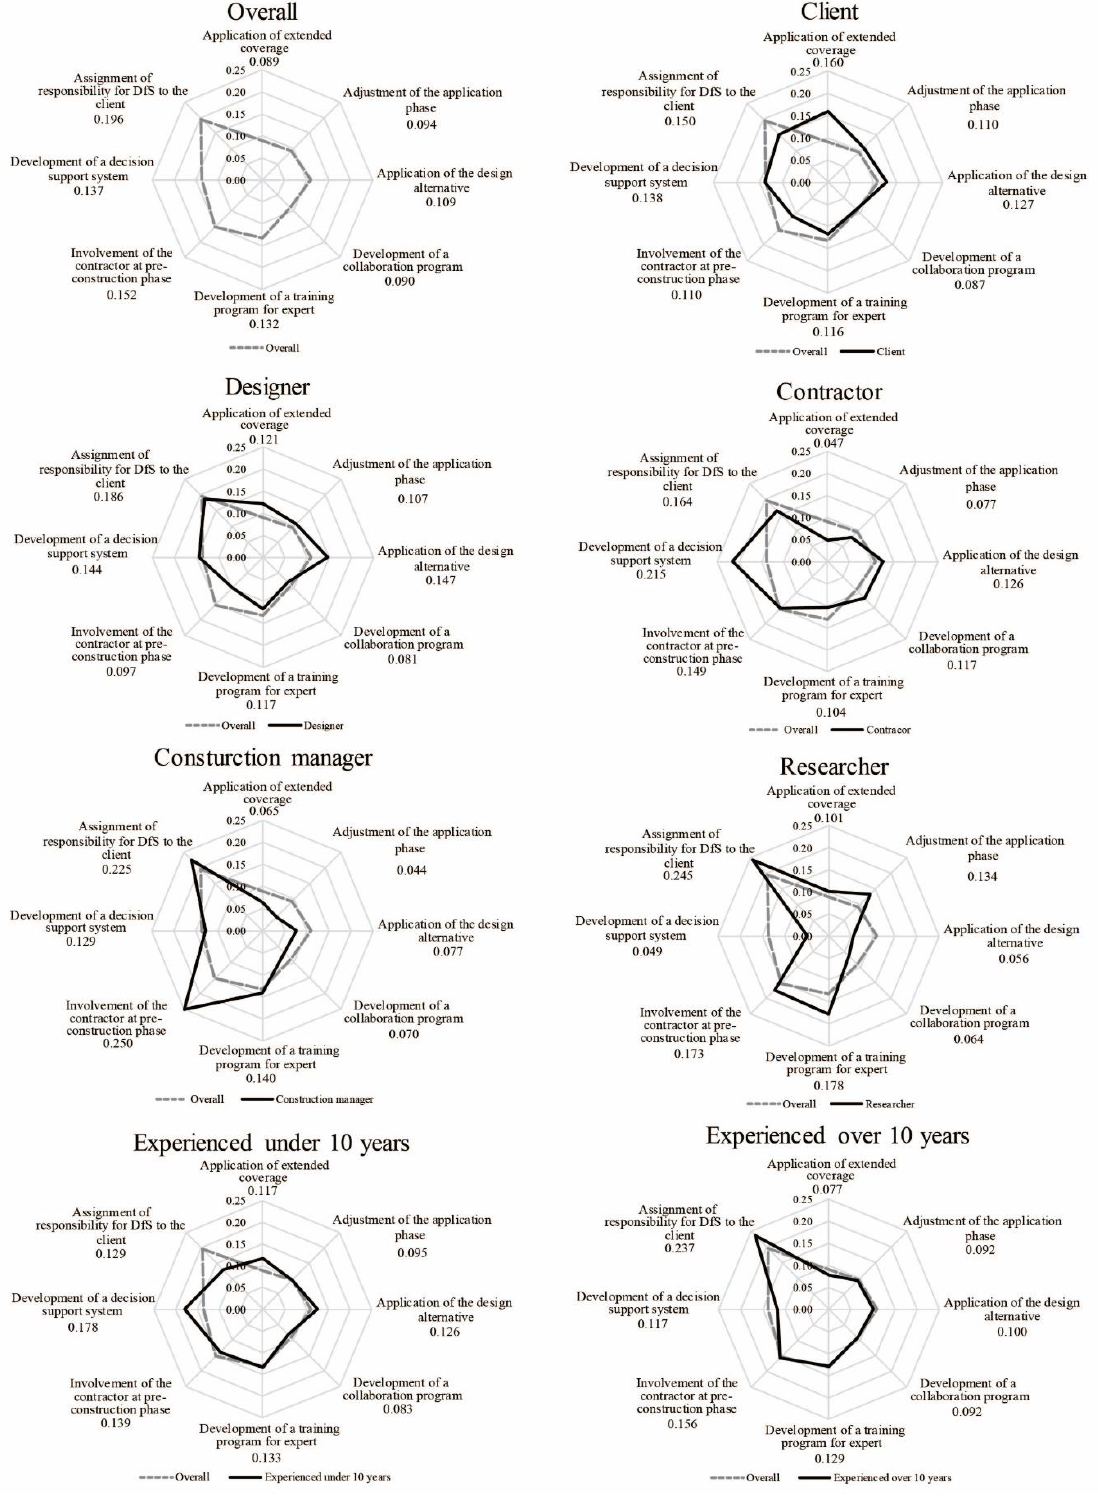
Figure 4. Results of importance’s fuzzy-analytical hierarchy process (F-AHP) analysis.